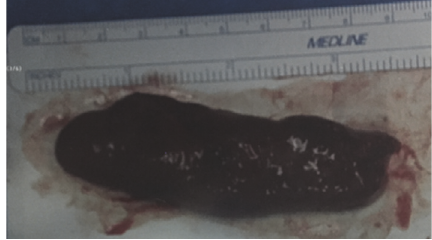
Figure 5: Gross specimen of polyp from case #2.